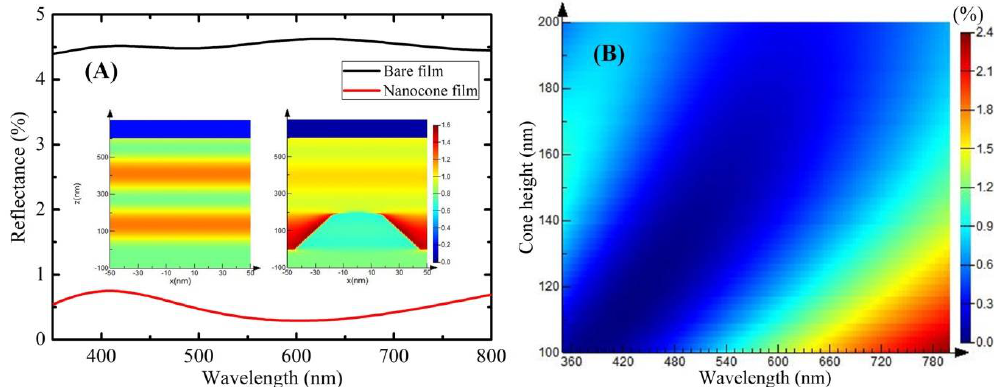
Figure 3. ( A ) Finite-difference-time-domain (FDTD) simulations of reflectance spectra and the cross-sectional electric field intensity distribution of electromagnetic wave at 550 nm wavelength; and, ( B ) Simulated integrated reflectance at different cone heights.